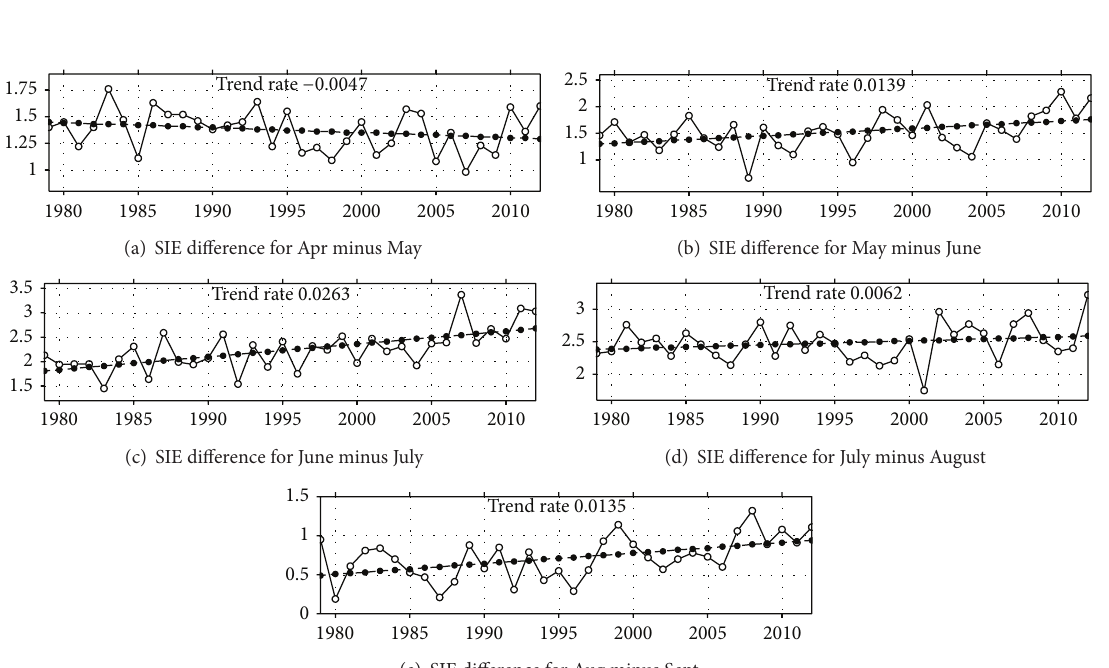
Figure 1: The time series of sea ice extent (SIE) differences and their linear curves (unit is millions of square kilometers) for 1979–2012: (a) for April minus May (AM), (b) for May minus June (MJ), (c) for June minus July (JJ), (d) for July minus August (JA), and (e) for August minus September